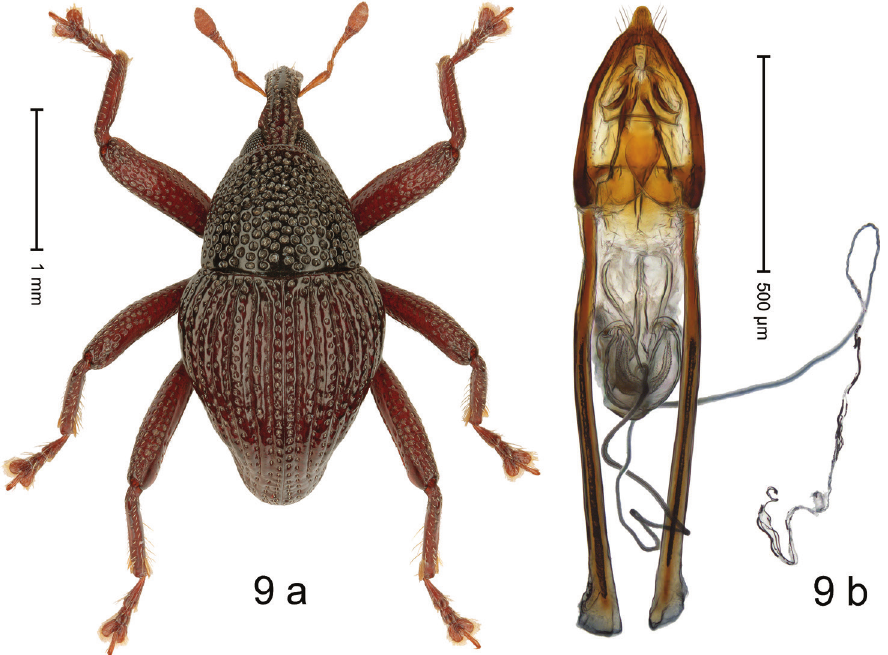
Figure 9. Trigonopterus hoppla sp. nov., holotype a habitus b